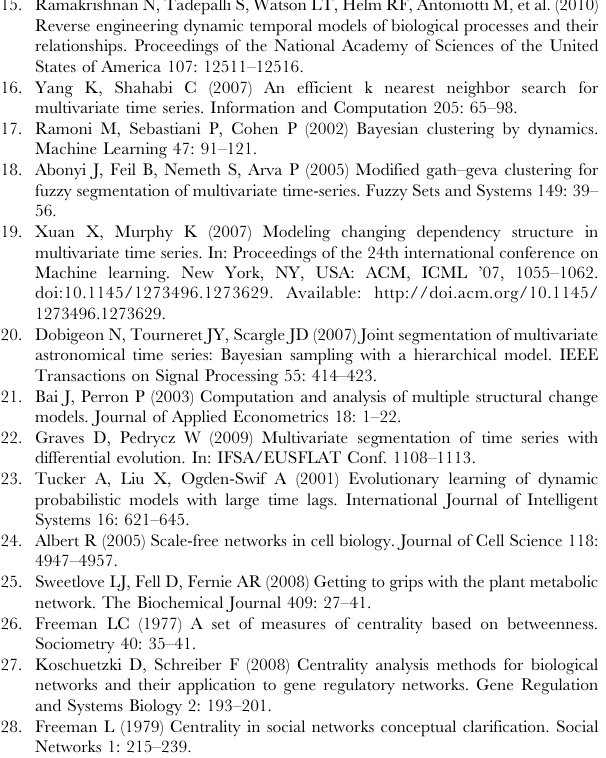
Table S3 Optimal segmentation for yeast’s cell cycle (YCC) data. The first part of the table comprises the result of the optimal segmentation for synthetic data based on general longest path algorithm Algorithm 1 (Fig. 3). The second and the third parts show the results based on penalized longest path algorithm using number of segments and distribution of length of the segments to calculate the penalty of a path, respectively. The lower part contains the result based on the method of Ramakrishnan et al. [15]. In the first part of the table, the first and second columns show the name and the type of network properties used to determine the distances: G stands for global, L for local, and LG for local-global. The third column includes the number k for each of the three methods and the resulting segments are given in the forth column. The fifth and sixth columns in the second and third parts present the values of lower ( n min ) and upper ( n max ) bound of the tuning parameter n with dynamic programming approach. The lower part also includes minimum and maximum length of the segments, i.e., l min and l max , as parameters of the contending method.